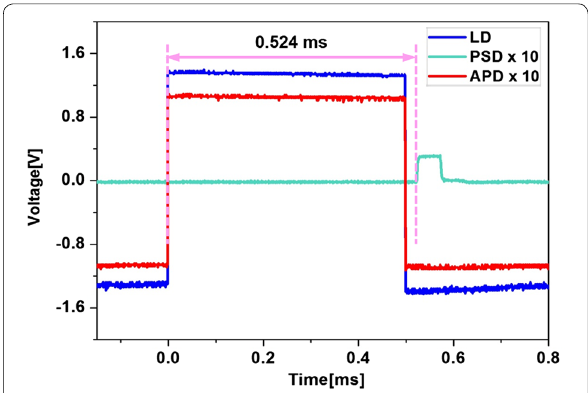
Fig. 4 LD input signal and output signals of the PSD and